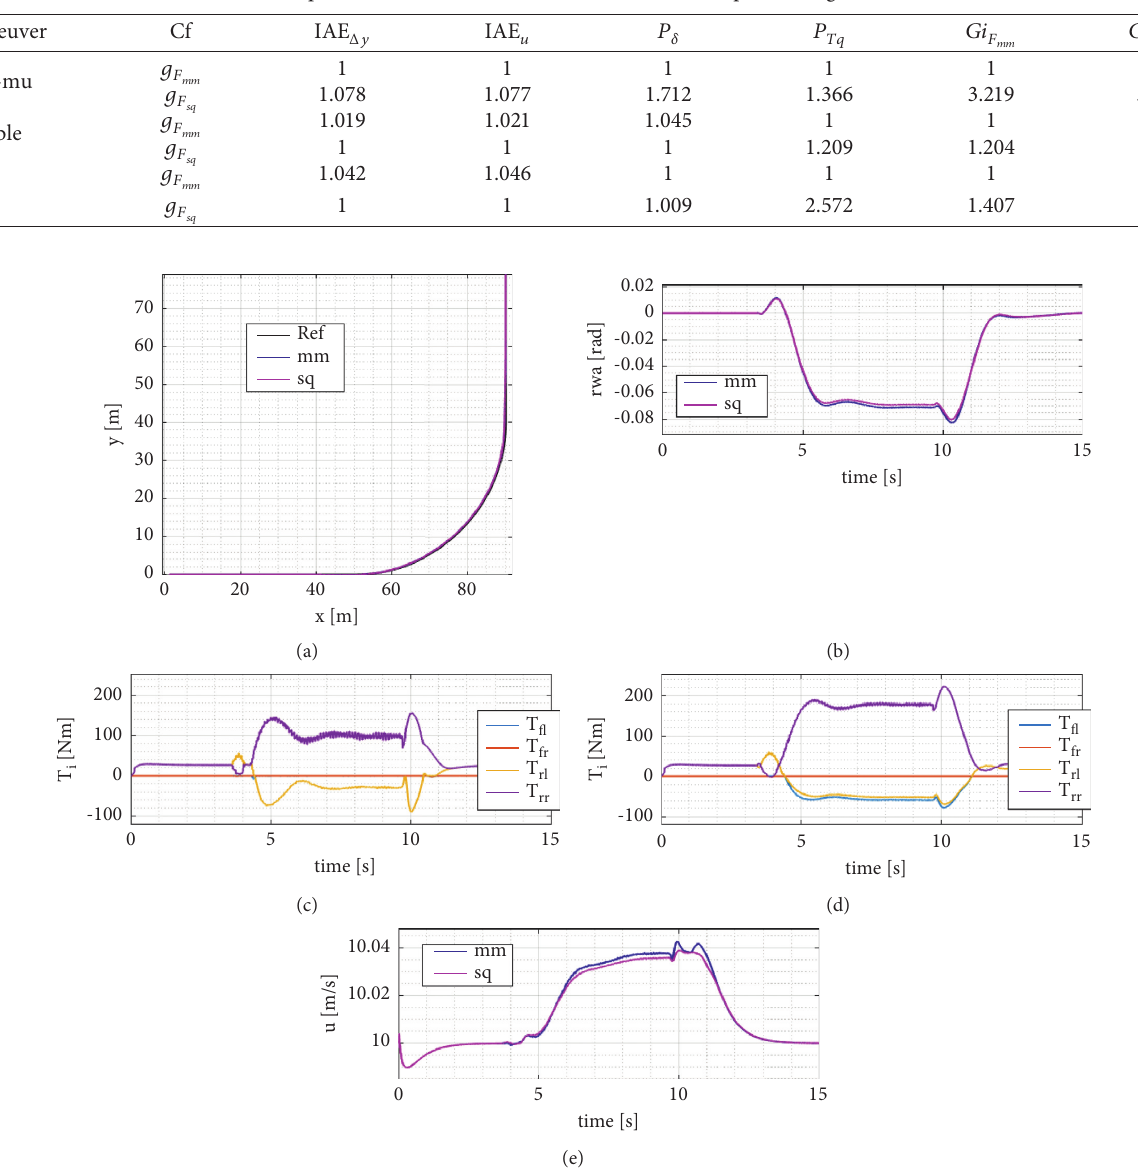
Table 3: Comparison of the two force-based cost functions performing the test cases.